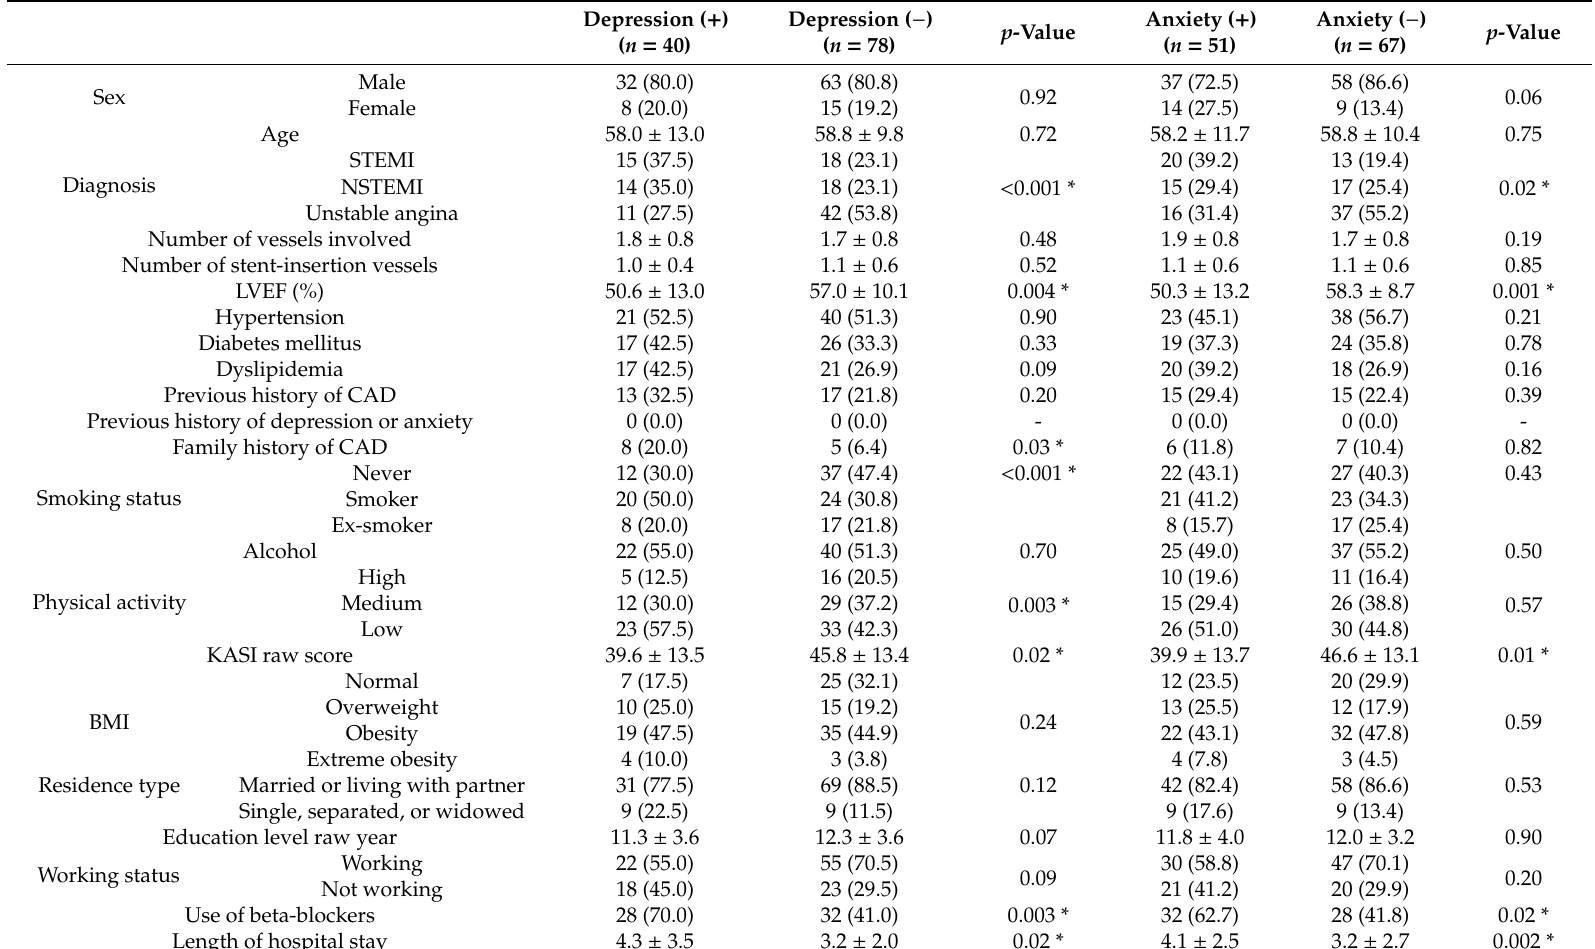
Table 2. Factors related to depressive and anxious moods in patients with